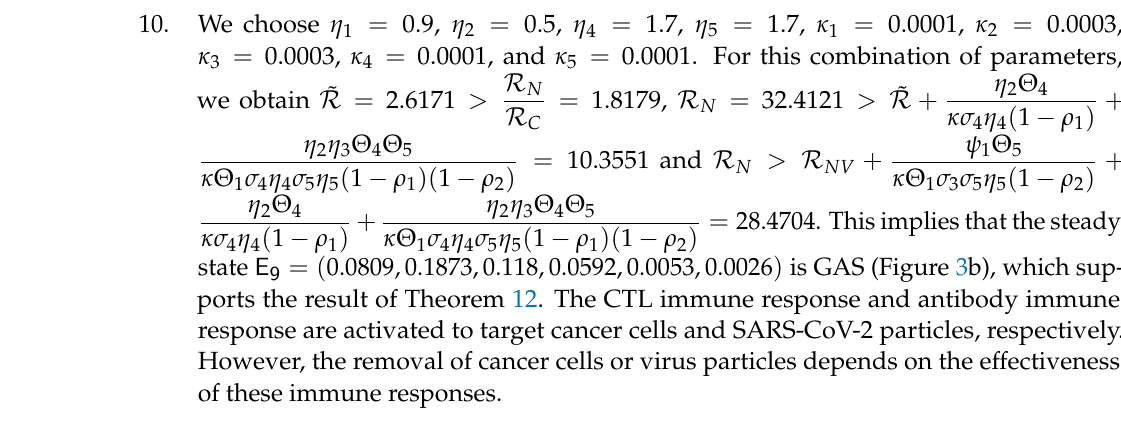
Table 1. The parameter values of model